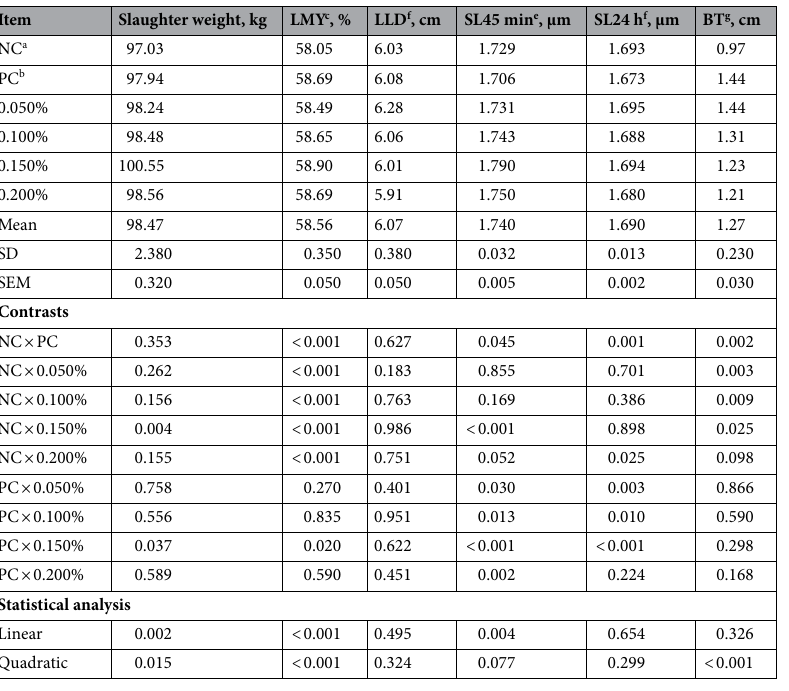
Table 3. Carcass traits and sarcomere length in longissimus lumborum muscle of 75–100 kg barrows fed diets containing different levels of inosine-5-monophosphate (5 ′ -IMP) and metabolizable energy (ME). a Negative control (0.00% 5 ′ -IMP and 3200 kcal ME/kg). b Positive control (0.00% 5 ′ -IMP and 3300 kcal ME/kg). c Lean meat yield. d Longissimus lumborum depth. e Sarcomere length at 45 min after slaughter. f Sarcomere length at 24 h after slaughter. g Backfat